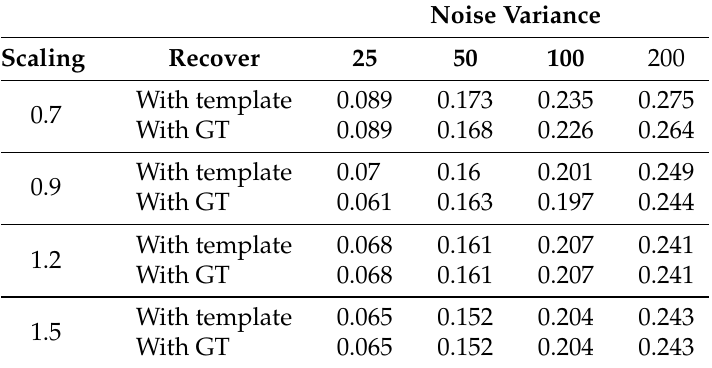
Table 3. Average BER for scaling attack with Gaussian noise.